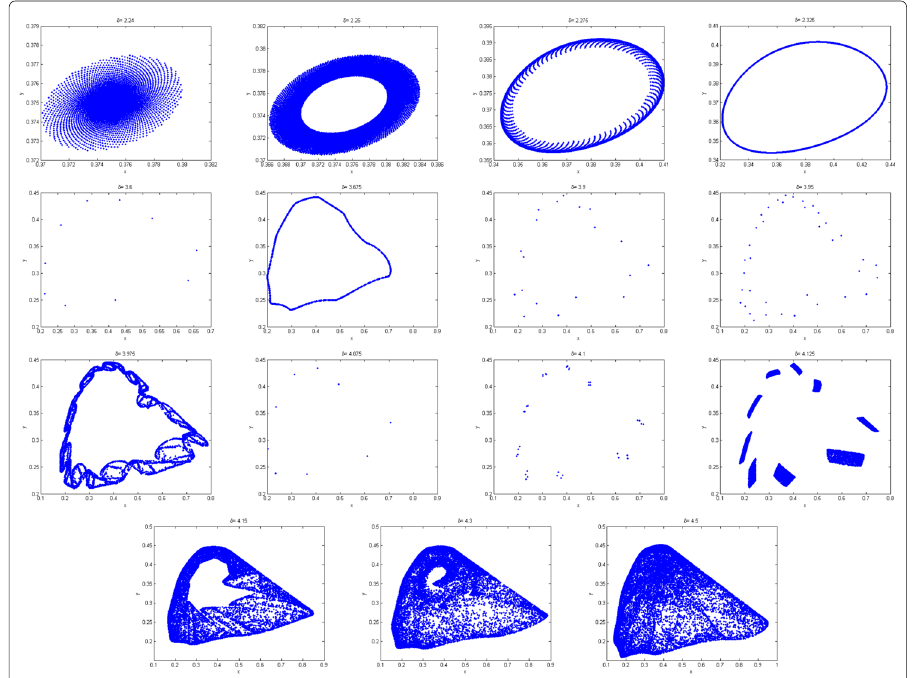
Fig. 3 Phase portraits for different values of δ corresponding to Fig. 2 a ,